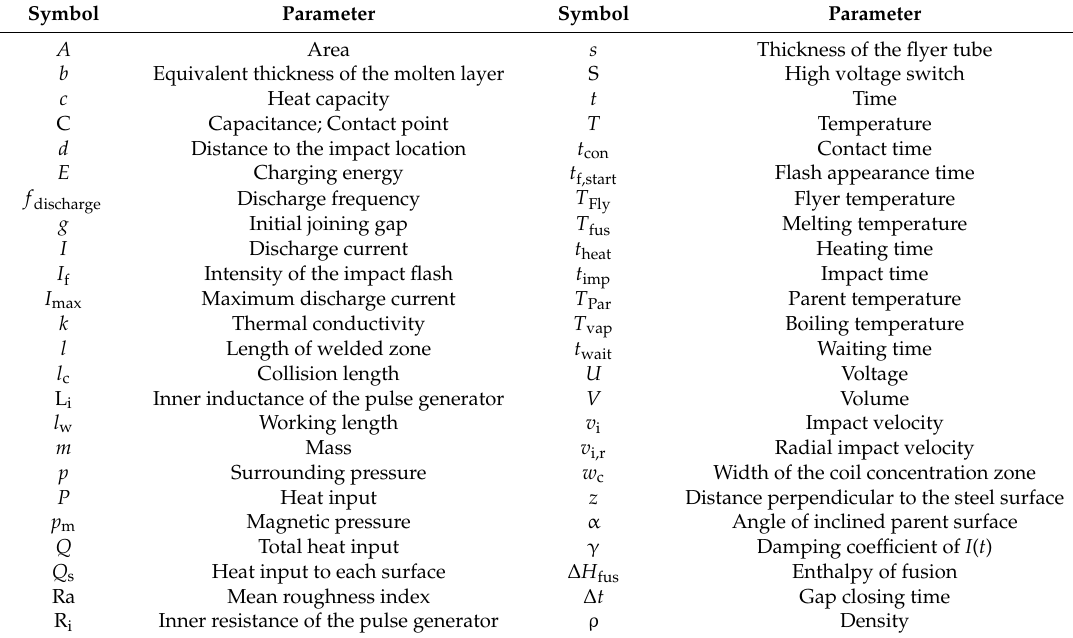
Table 1. Nomenclature for experimental and numerical